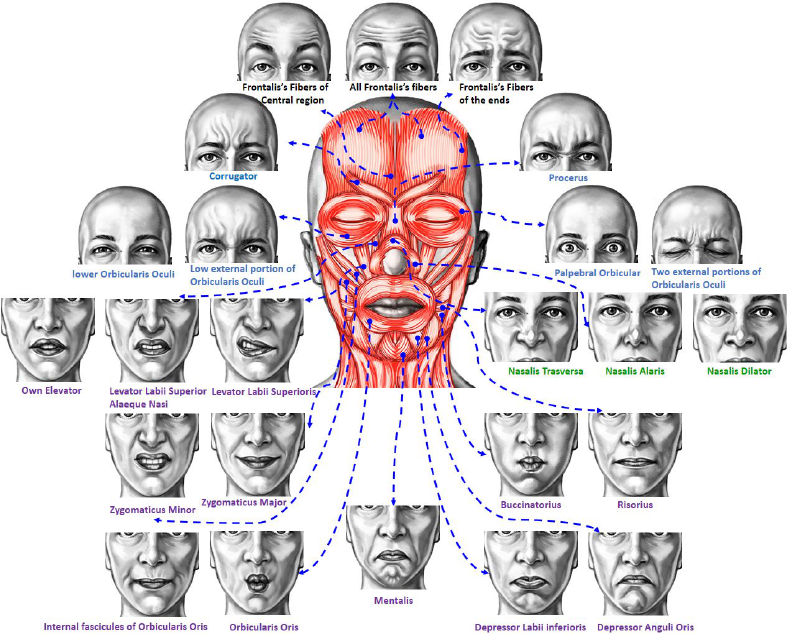
Figure 1. Human facial muscles that are responsible for different expressions. This illustration was designed using images generated by ARTNATOMIA